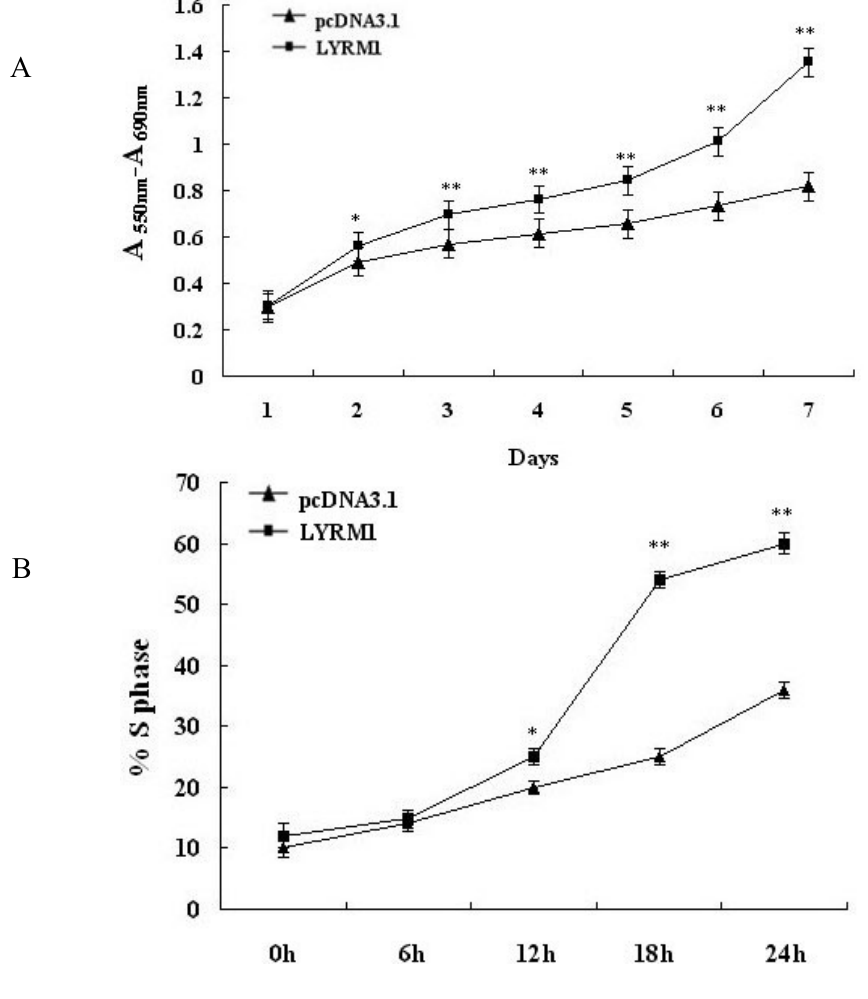
Figure 2. Effect of LYRM1 on cell proliferation. The growth of cells was detected by MTT assays (A) and cell cycle analysis (B). Ectopic expression of LYRM1 increases P19 cells proliferation. The figure represents one of three independent experiments ( * P = 0.001, ** P <